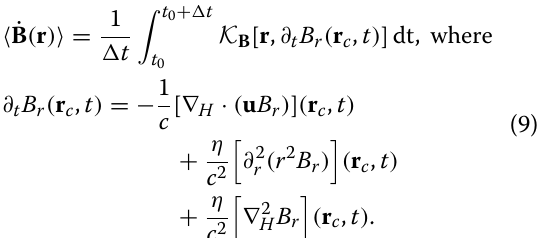
Fig. 1 Forecast error measuring the difference between the true field at epoch t and a linear extrapolation between t 0 and t , with t 0 division). Each Gauss coefficient has a constant rate of change, which is set either to the value of its time derivative at t 5 years (orange curve). Fields are expanded up to spherical harmonic degree and order average rate of change between t 0 and t 0 +